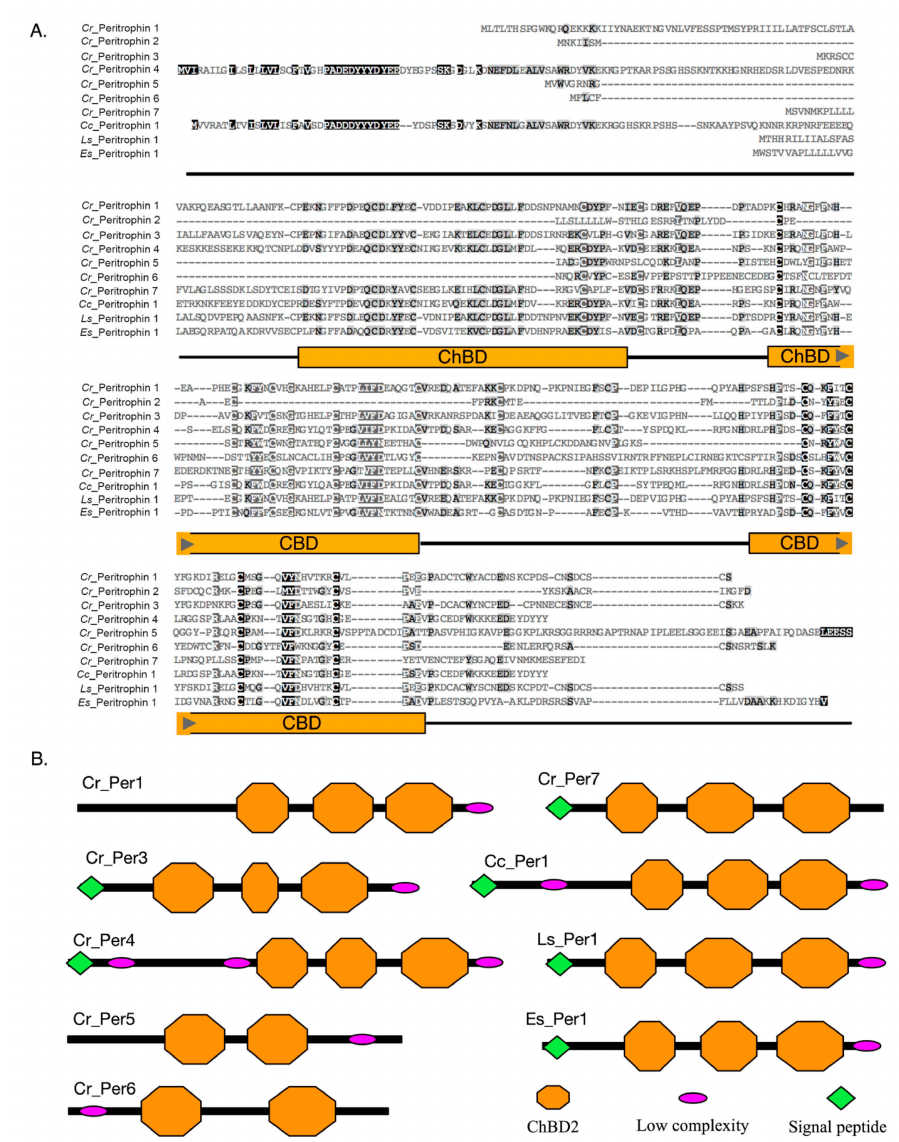
Figure 2. Amino acid sequences analysis of peritrophins identified in C. rogercresseyi . ( A ) . Multiple alignments of the Cr_Per protein with other crustacea peritrophin proteins deposited in GenBank. The dark gray region indicates the positions where all the sequences share the same amino acid residue, and oranges boxes represent chitin-binding domains. ( B ) . The predicted domain structure of the peritrophin-like proteins of C. rogercresseyi (Cr). Cc: Caligus clemensi [ACO14568.1], Ls: Lepeophtheirus salmonis [ADD24486.1], Es: Eriocheir sinensis